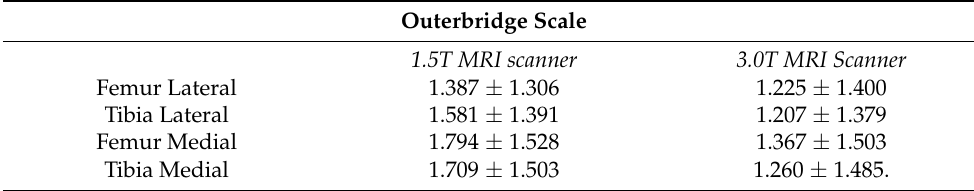
Table 4. Outerbridge Scale for each compartment of femorotibial